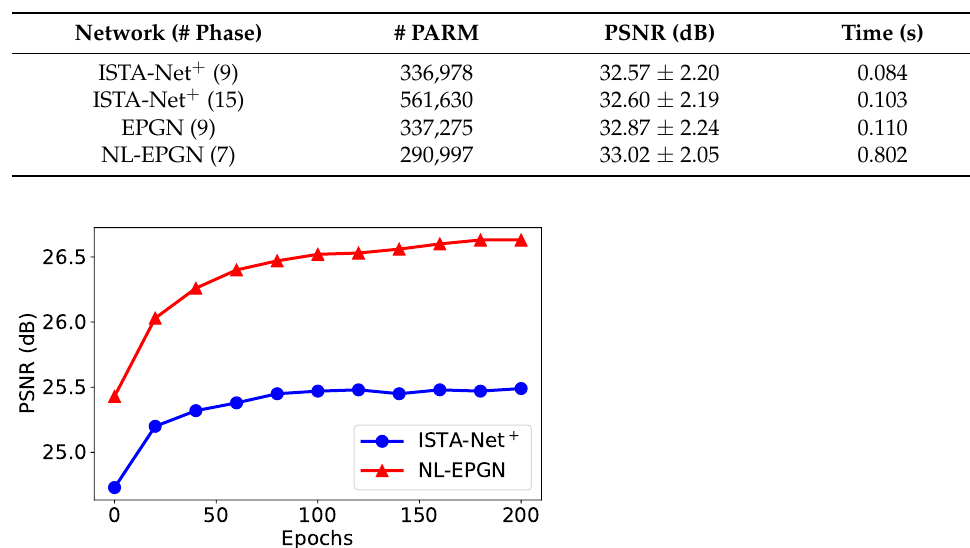
Table 2. Compressive sensing reconstruction performance comparison of the 9-phase ISTA-Net + , 15-phase ISTA-Net + , 9-phase EPGN, and 7-phase NL-EPGN on Set11 with a CS ratio of 25% on the number of network parameters (# PARM), average PSNR in dB with standard deviation over the reconstructed images, and average reconstruction time (Time) of one image in second.